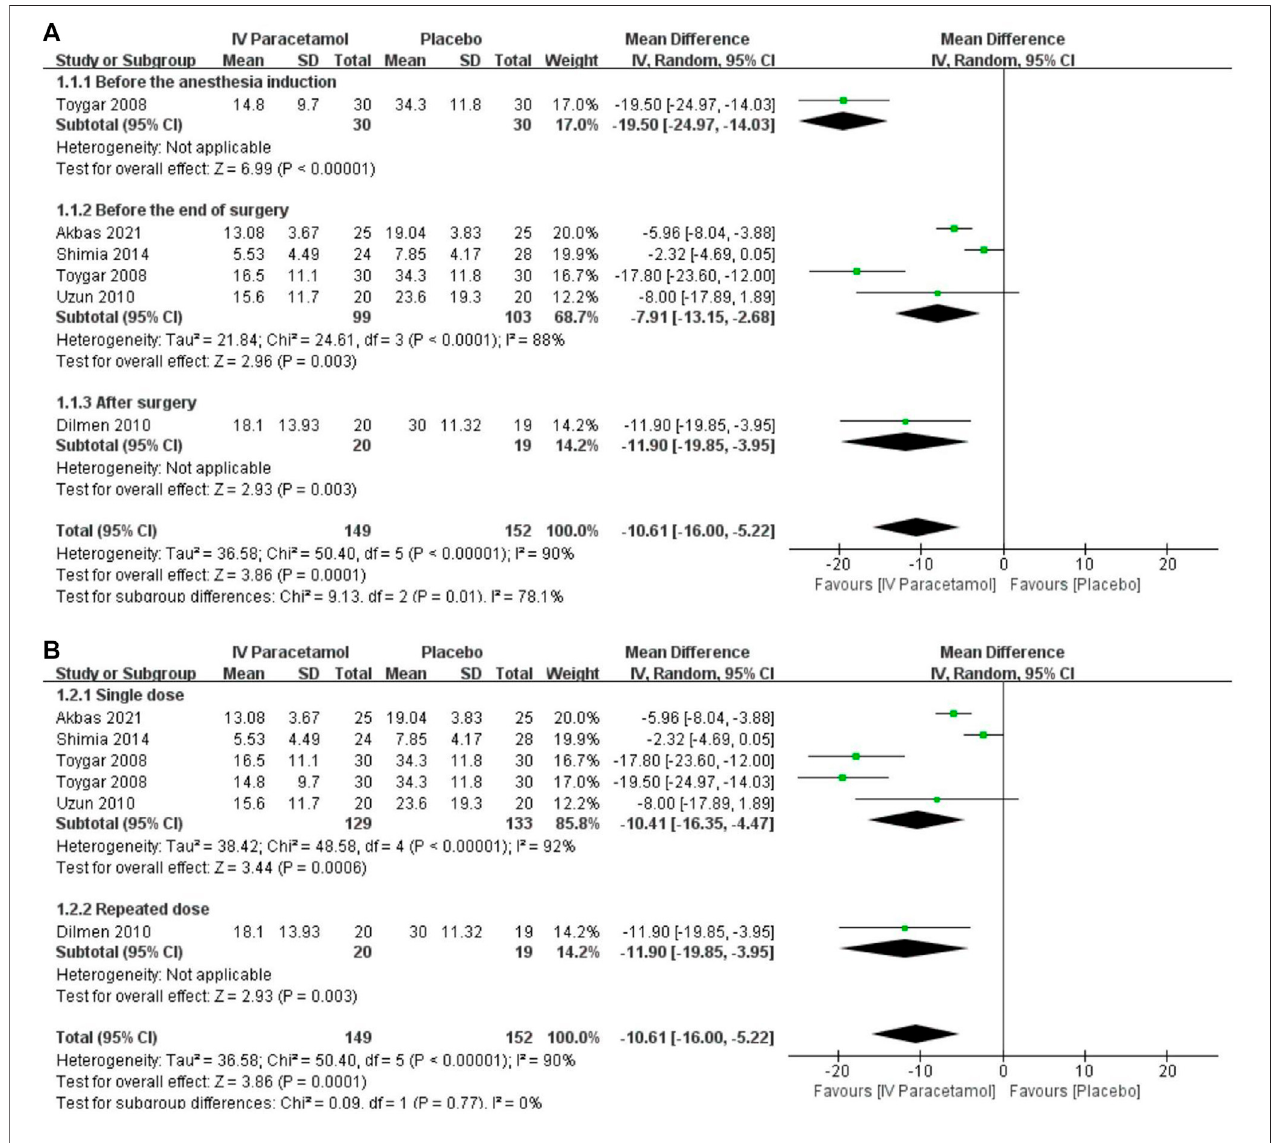
FIGURE3| Forestplotshowingthe24-hmorphineconsumptionpostoperatively(mg)withsubgroupanalysespresentedaccordingtothe (A) timeand (B) doseof intravenous paracetamol used. IV, intravenous. SD, standard deviation. CI, con fi dence interval.